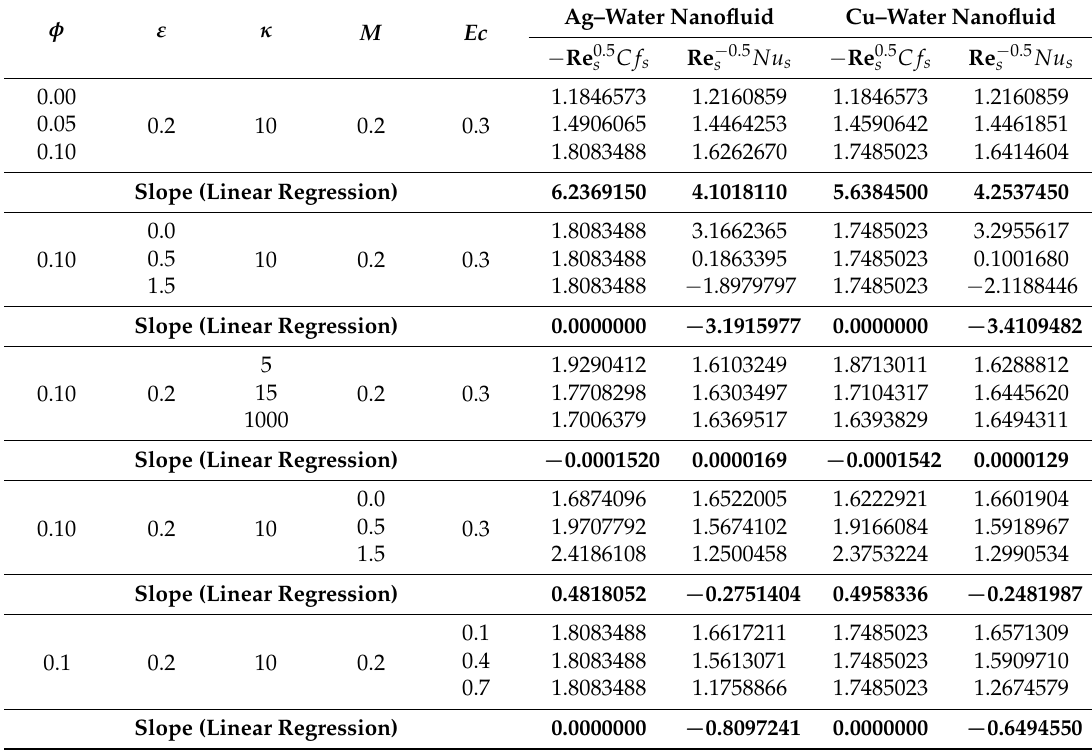
Figure 7. Effects of temperature difference parameter M = 0.2, φ = 0.01, ε = 0.2, and Ec = 0.3. Table 6. Impact of the emerging parameters φ , ε , κ , M , and Ec on the engineering quantities − Re 0.5 s Cf s and Re − 0.5